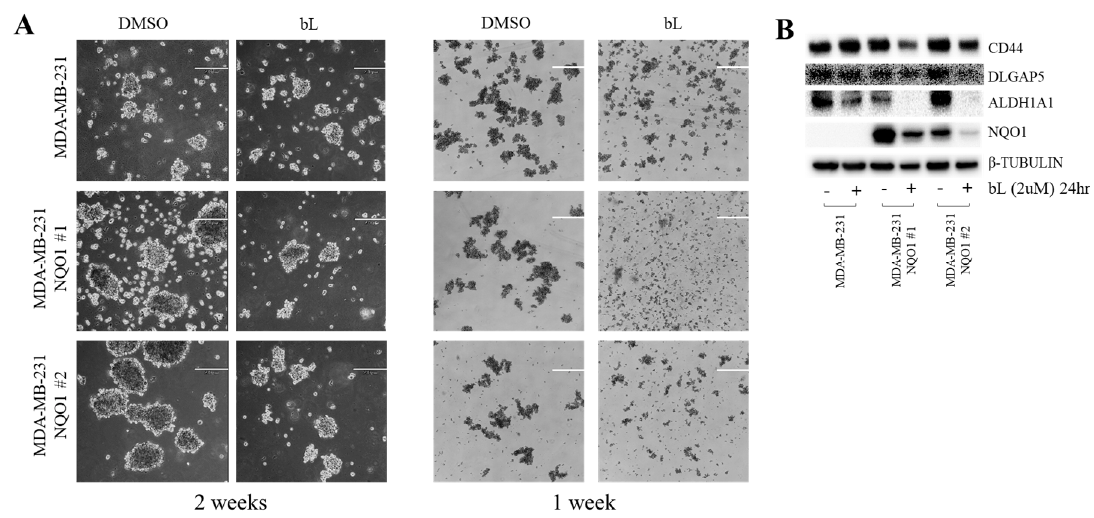
Figure 6. The bL compound inhibits mammosphere formation. ( A ) MDA-MB-231 and two independent clones of NQO1 stable cells (NQO1 #1 and #2) were induced to mammosphere formation for one and two weeks, as described in Section 4. After mammosphere formation, bL (2 µ M) was added for 24 h. Images were taken using a new hybrid microscope (Echo, San Diego, CA, USA). The scale bar is 200 µ m. ( B ) Cell lysates obtained from the mammosphere formation assay were subjected to Western blot analysis using the indicated antibodies; β -tubulin was used as a loading control.